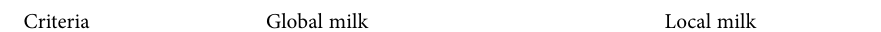
Table 3. Description of the case studies along the criteria of local-global distinction (Brunori et al .,